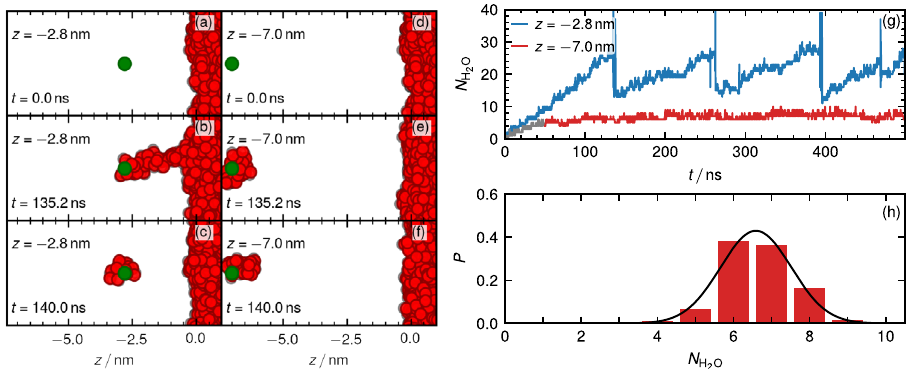
Fig. 2 Ion held at fi xed position. Simulation protocol (II) where an ion is con fi ned to a harmonic potential fi xed at different z positions. Simulation snapshots at different times are shown for z = − 2.8 nm ( a – c ) and z = − 7.0 nm ( d – f ). g Number of water molecules N H around the ion for two different positions as a function of time, initially N simulation are discarded for equilibration. The black solid line is a Gaussian fi t from which the free energy for N H